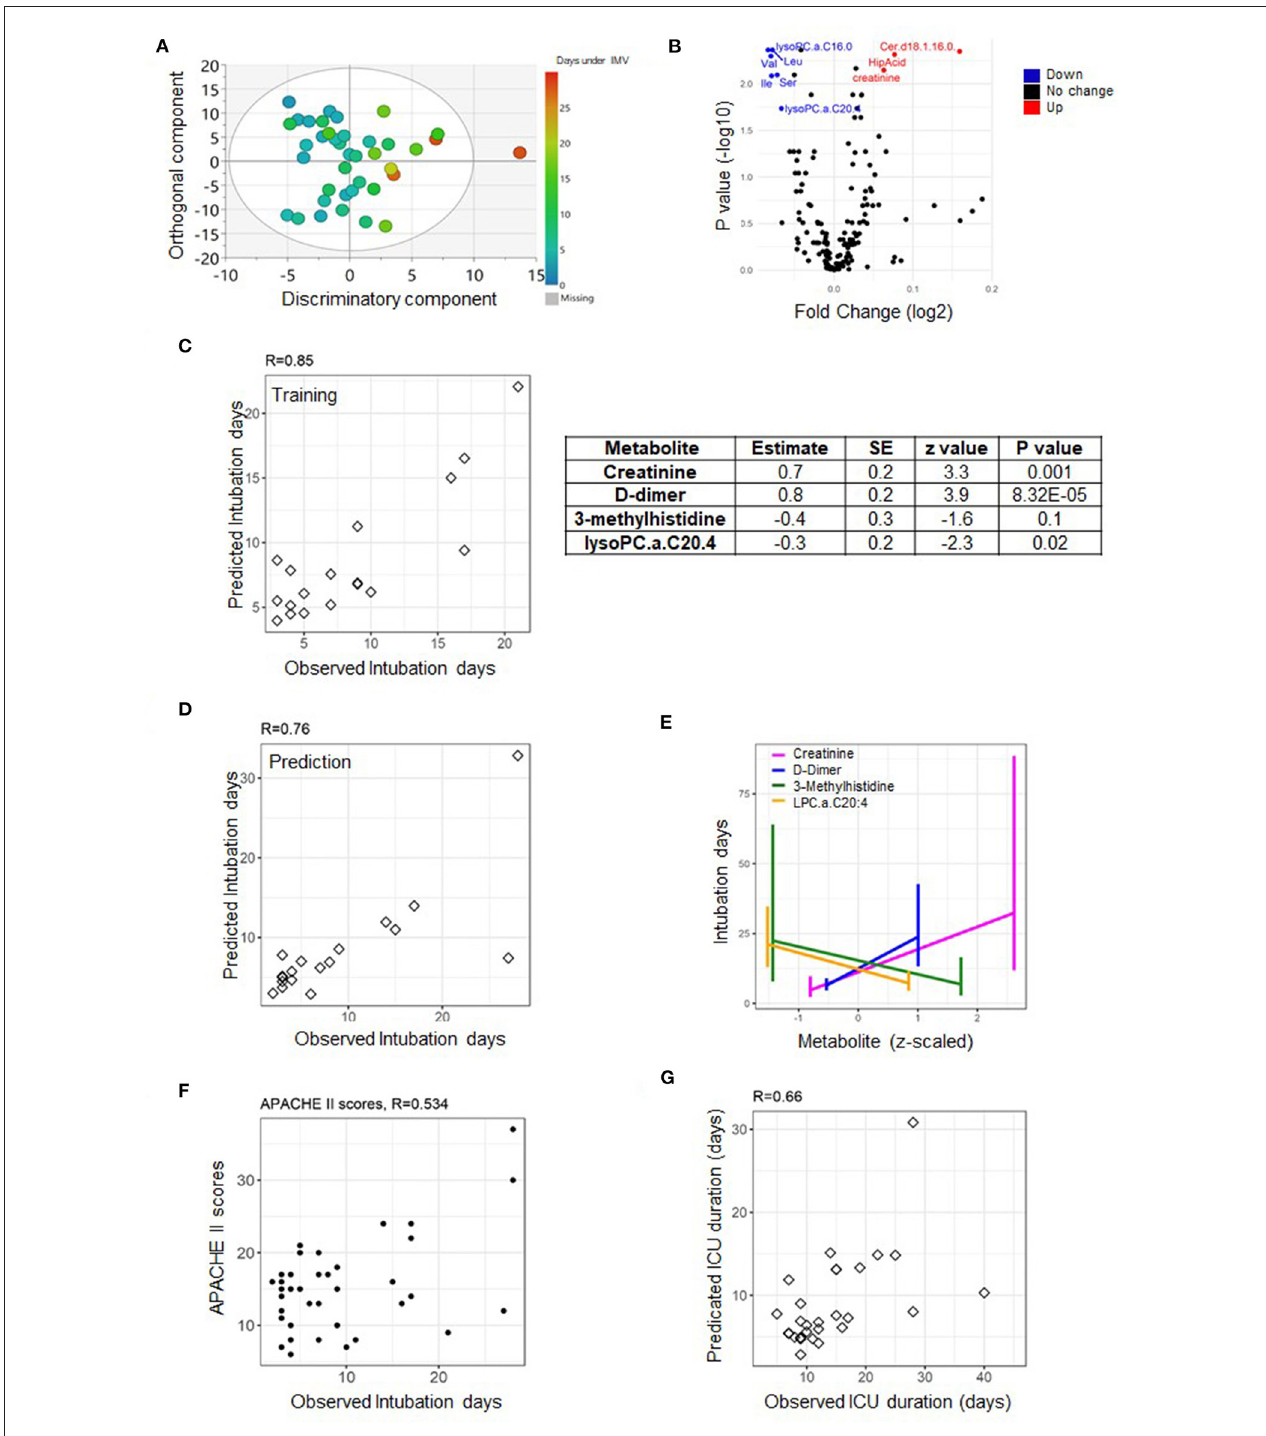
FIGURE 3 | Predictive model of duration of invasive mechanical ventilation (IMV) based on measurements from day one. An OPLS score plot showing the class-discriminatory component ( x -axis) vs. orthogonal component ( y -axis) for duration of IMV, the discriminatory component explaining up to 86% of the variation in the Y phenotype variable (A) . A volcano plot showing top associated metabolites (log fold change > 0.06, adjusted p ≤ 0.05) with duration of IMV from the linear model based on the training set (B) . The predictive model was trained on metabolites and clinical traits measured from the training set ( n = 17) on day one (C) , then validated on the prediction set ( n = 16) (D) . The model comprised of three metabolites and one clinical trait (E) that together showed a better predictive power compared to APACHE II score (F) . Using the model to predict the highly correlated number of days at ICU produced a correlation level of 0.66 with their observed counterparts (G) .